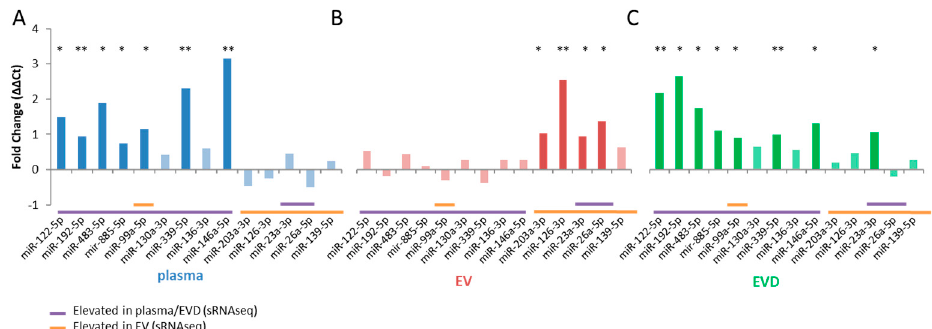
Figure 3. qRT-PCR validation of sRNAseq results in plasma, EVs, and EV-depleted (EVD) plasma. Log2FC for plasma ( A ), EVs ( B ) and EVD ( C ). qRT-PCR validation of sRNAseq data for selected miRNAs in plasma ( A ), EVs ( B ), and EVD fractions ( C ). Results are shown as ∆∆ Ct values (max cycles − (Ct reference − Ct target). MiR-451a and miR-486-5p were used as standards. Statistically significant results are designated by asterisks (* p < 0.05, ** p < 0.01). Results with p > 0.05 are greyed-out. Corresponding sRNAseq results are shown below as either purple bars (elevated in plasma / EVD) or yellow bars (elevated in EVs).